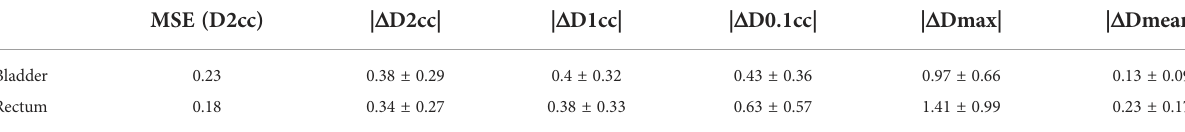
TABLE 2 Model performances for bladder and rectum.